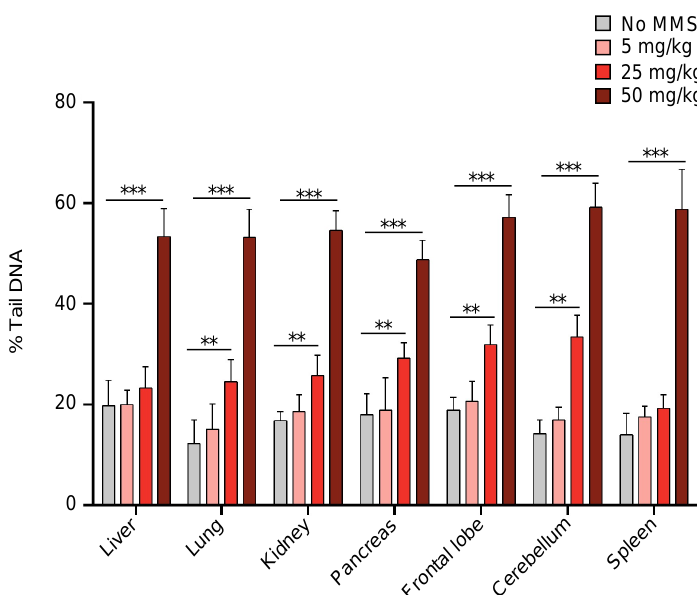
Figure 2. MMS-induced DNA damage can be detected in various mouse tissues using the CometChip. Mice were either sham treated or treated with MMS and various tissues were collected 3 hours after injection and analyzed with the alkaline CometChip. ( A ) Example of fluorescent comet images from various mouse tissues exposed to varying doses of MMS. ( B ) Dose – response graphs of mice exposed to 0, 5, 25 or 50 mg/kg of MMS. All samples were analyzed in parallel on the same chip. Percent tail in DNA represented as mean of three mice ± SD . Unpaired Student’s t -test, ** p < 0.01, *** p < 0.001. Scale bar = 100 μ m.